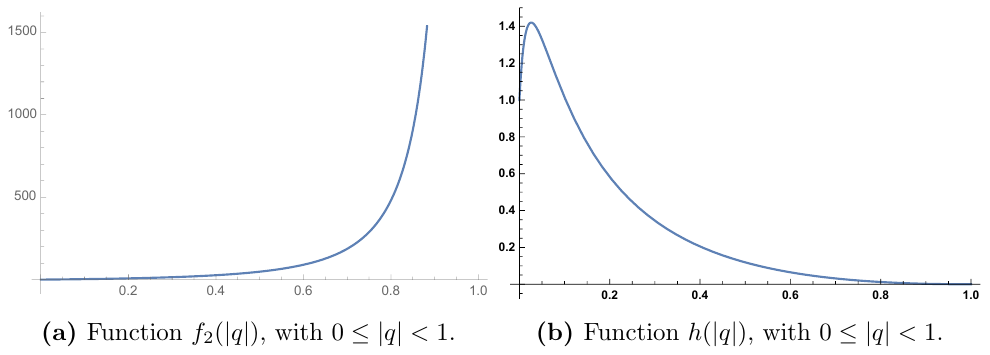
Figure 3. Behaviour of the functions f 2 ( j q j ) and h ( j q j